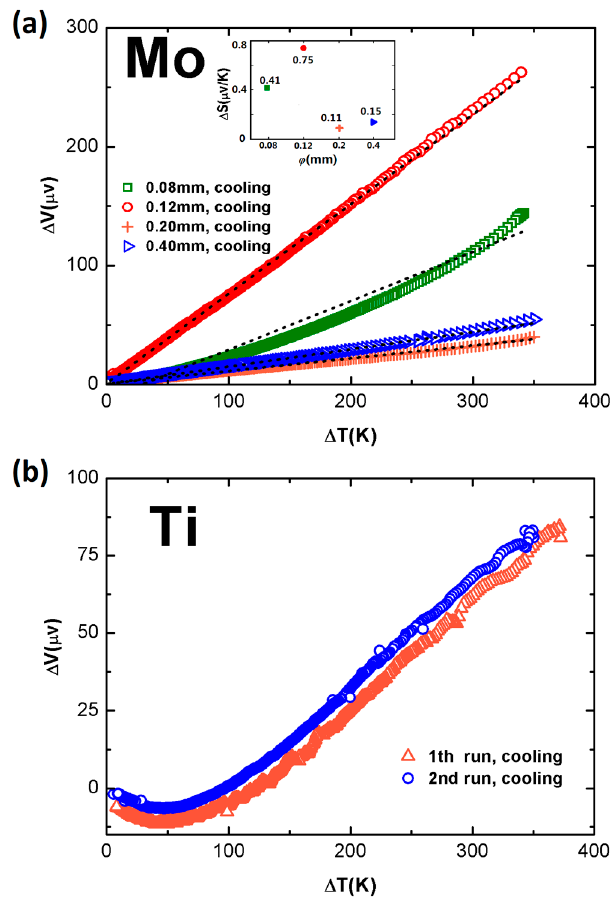
Figure 8. Measurement results for a bunch of thick-wire, thin-wire dual-arm samples made from ( a ) Mo wires; and ( b ) Ti wires.